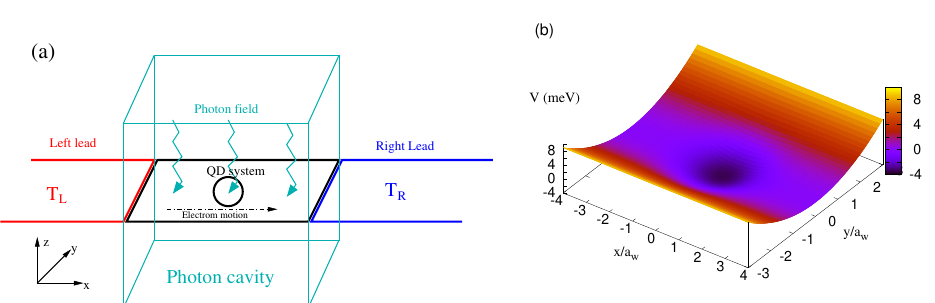
Figure 1. ( a ) Schematic diagram showing the quantum dot (QD) system (black) connected to the leads or the electron reservoirs, where the temperature of the left electron reservoir ( T L ) (red) is higher than the temperature of the right electron reservoir ( T R ) (blue). The cyan zigzags represent the photon field in the cavity (cyan rectangle). ( b ) The potential of the QD system to be connected diametrically to the left and right leads in the x